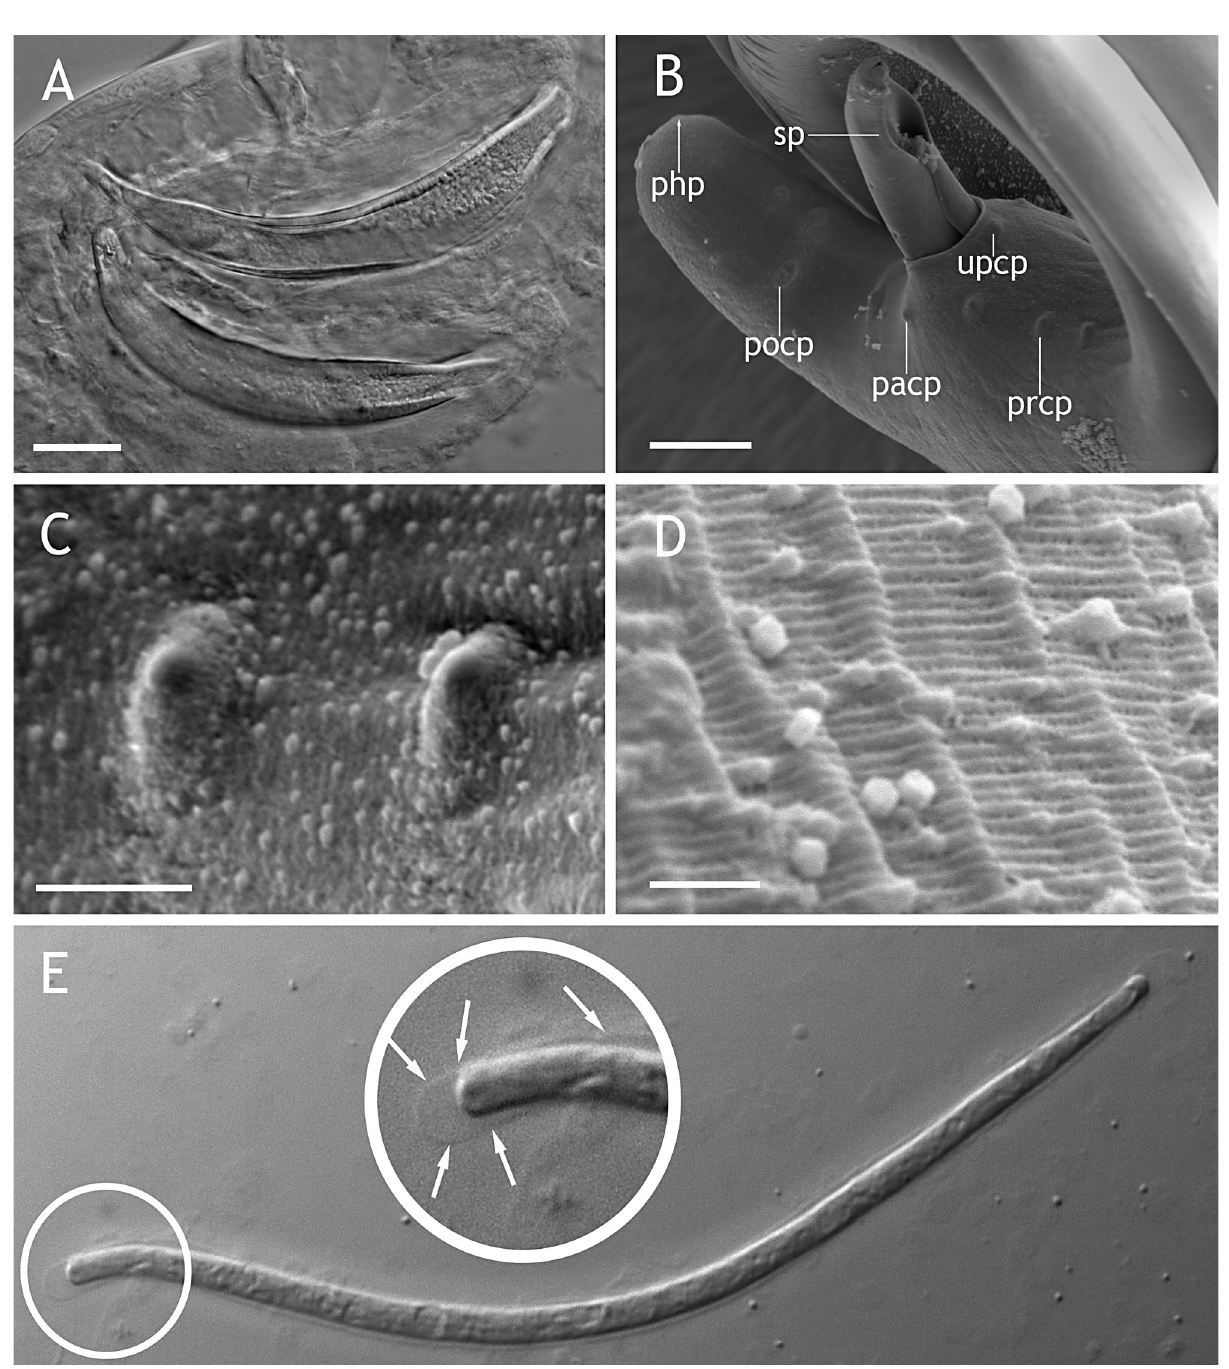
23-31Fig. 3. – A. Spicules; scale bar = 20 µm. B. The posterior end of the male as seen in SEM; sp = spicule, prcp = precloacal papilla, upcp = unpaired precloacal papilla, papc = paracloacal papilla, pocp = post-cloacal papilla, php = phasmidial pore; scale bar = 20 µm. C. Area rugosa as seen in SEM, showing cuticular bosses and two precloacal papillae; scale bar = 5 µm. D. Cuticular surface in SEM showing trans- verse ridges and delicate longitudinal striation with tiny cuticular bosses; scale bar = 1 µm. E. Microfilaria, 5 µm wide, in the peripheral blood of the reindeer; the arrows indicate the sheath in close-up